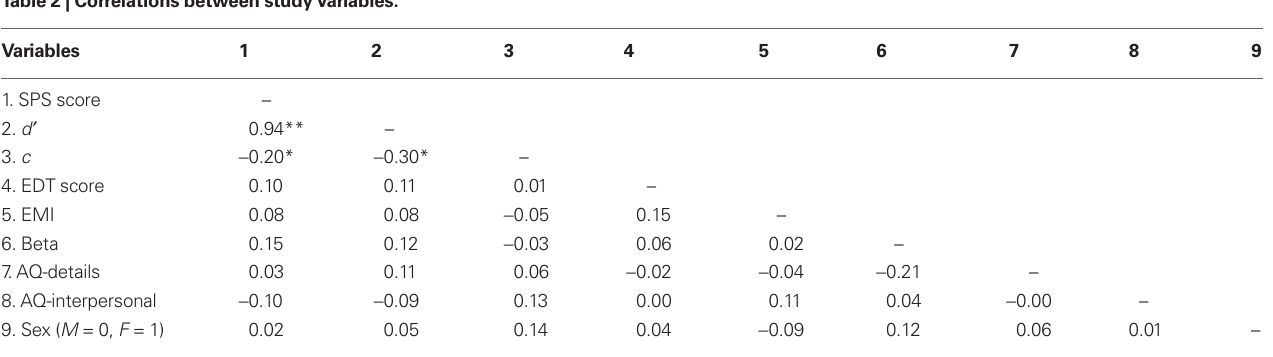
Table 2 | Correlations between study